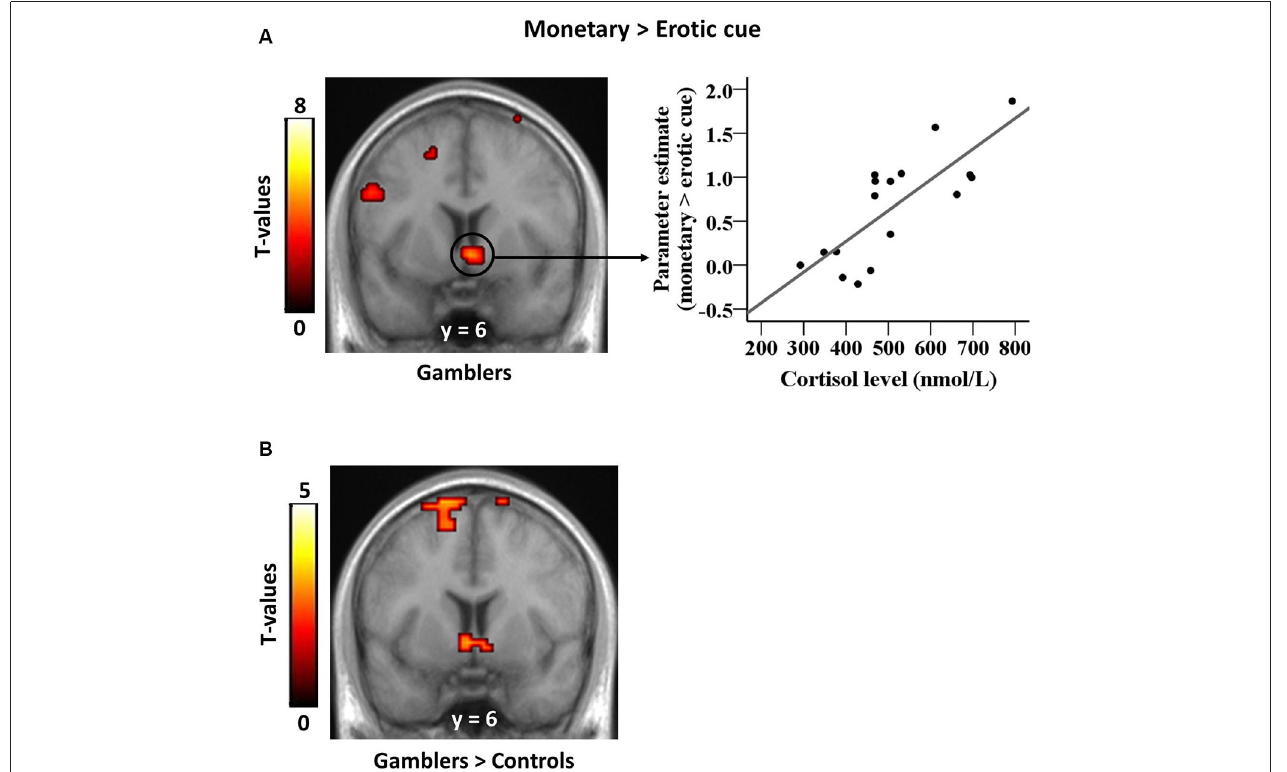
significant striatal voxels extracted from the whole-brain map. (B) This correlation between ventral striatal responses to monetary versus erotic cues and basal cortisol levels is stronger in gamblers than in healthy